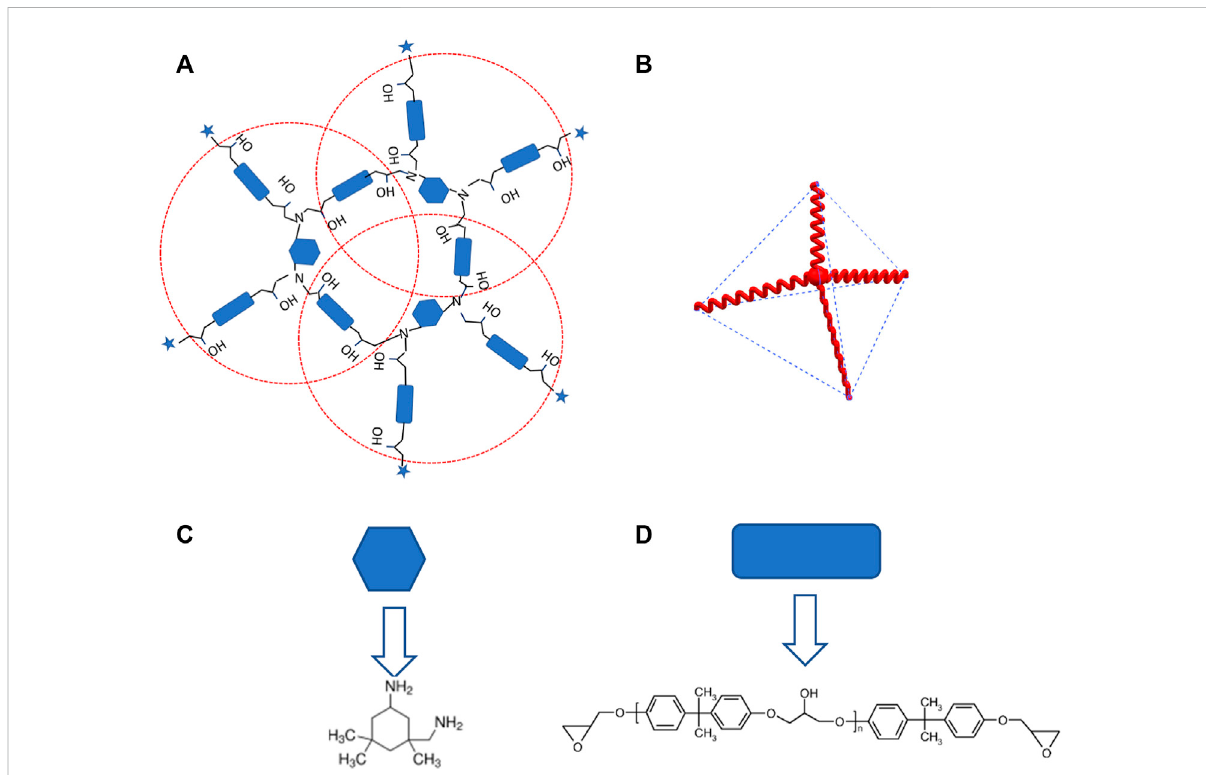
FIGURE 5 (A) Planar schematic for the molecular con fi guration of the EPON-IPD network; (B) unit cell in the EPON-IPD network; (C) monomer of isophoronediamine(IPD); (D) partialstructureoftheepoxyresin(EPON826); + representstheextendedstructure.Foreachdottedredcirclein (A) ,it consistsofoneIPDatthecenter,connectedbyfourepoxyarms,whicharetheEPONepoxymonomers.Inthreedimensions,thisplanarschematicis represented by the tetrahedron unit cell in (B) . From (A) , it is seen that every epoxy monomer arm is shared by two-unit cells, growing into the three-dimensional space network. [Reproduced with permission from Journal of Applied mechanics, 87(6): 061007, (2020a). Copyright 2020 American Society of Mechanical